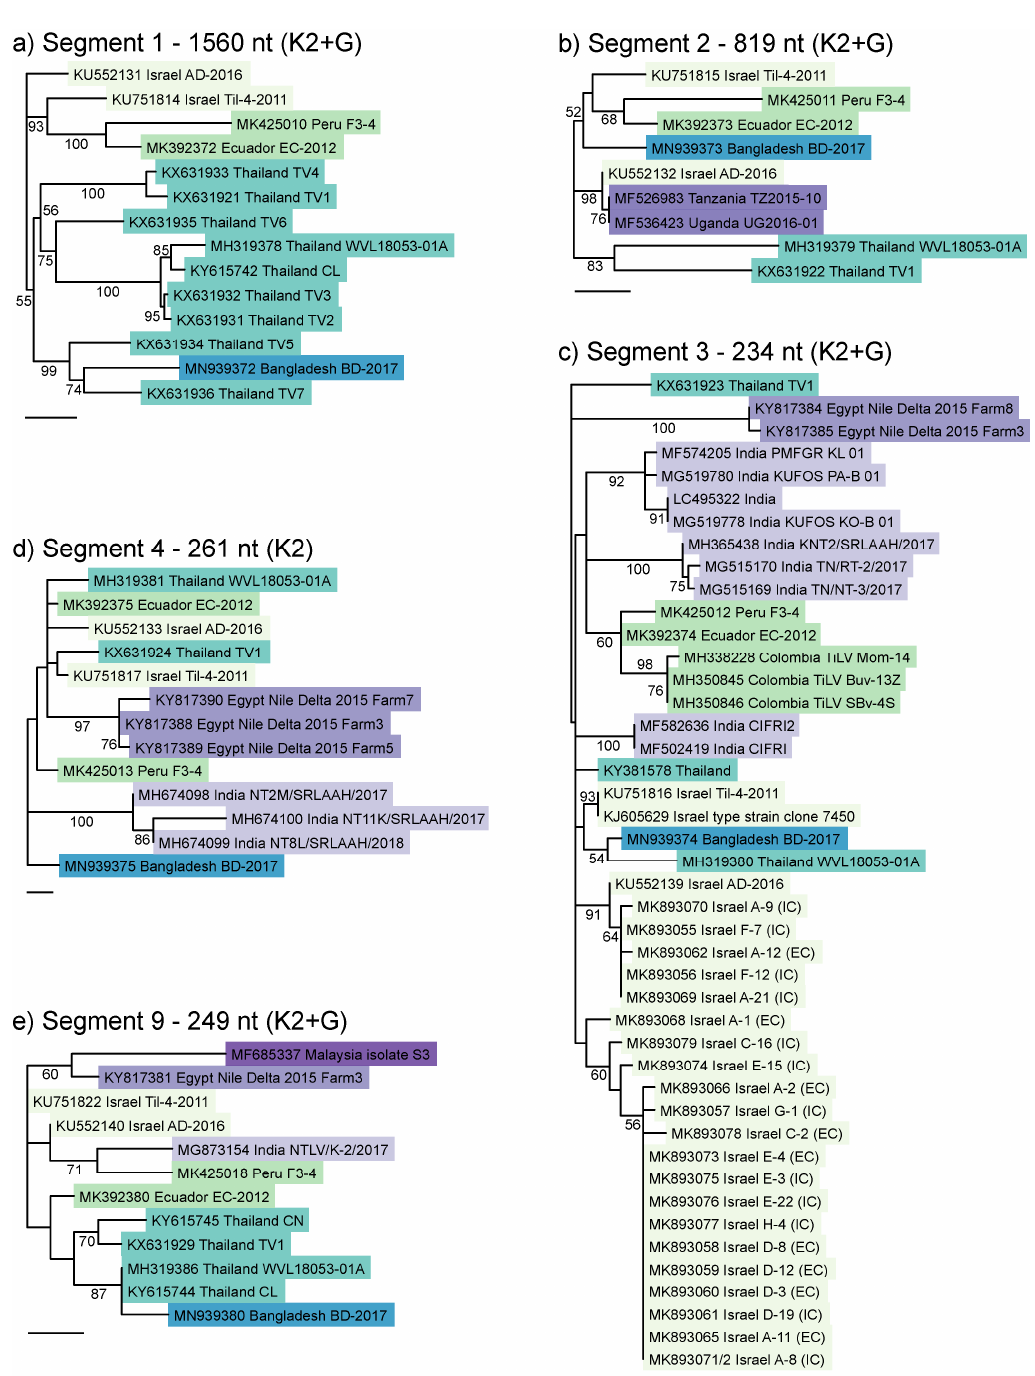
Figure 3. Maximum likelihood phylogenetic trees of the five TiLV segments for which additional reference sequences were available in GenBank. ( a ) Segment 1; ( b ) Segment 2; ( c ) Segment 3; ( d ) Segment 4; ( e ) Segment 9. Alignment lengths and best-fitting nucleotide substitution models are shown in panel headings (K2 = Kimura 2 parameter model, +G = gamma-distributed rate heterogeneity). Bootstrap values were calculated from 1000 replicates, and percent support is shown on nodes where values exceed 50%. Scale bars show 0.01 substitutions per site. Colours show isolates from the same region.